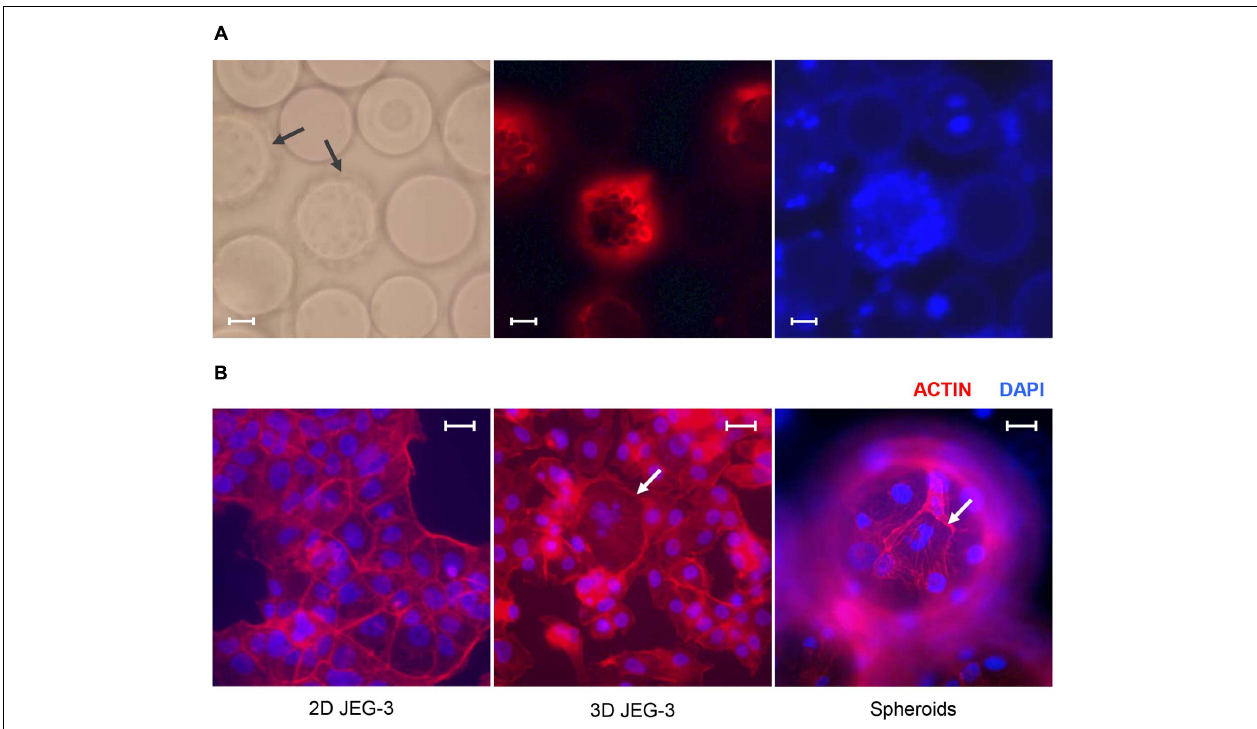
FIGURE 1 | JEG-3 cells grown in the RWV bioreactor fuse to form syncytia. (A) Micrographs of JEG-3/HBMEC spheroids cultured for 20 days. Cell membranes were stained with Texas Red R (cid:13) 1,2-dihexadecanoyl- sn -glycero-3-phosphoethanolamine, triethylammonium salt (Texas Red R (cid:13) DHPE, red). Left: bright-field. Center : Texas Red R (cid:13) DHPE. Right: 4’, 6-diamindino-2-phenylindole (DAPI). Arrows point to cell coated beads (spheroids). (B) Staining of actin filaments in monolayers of 2D JEG-3 cells (left) or 3D-cultured cells, either detached from beads (center) or on 3D-grown spheroids (right). Cells were fixed/permeabilized and stained with Alexa Fluor R (cid:13) 680 phalloidin (red). Arrows point to syncytia. Slides were mounted with Vectashield mounting medium containing DAPI (blue) to visualize nuclei. Fluorescent micrographs are representative of three independent experiments and were acquired on a Keyene BZ-9000 fluorescence microscope. Scale bars: 50 µ m in (A) and 30 µ m in (B)